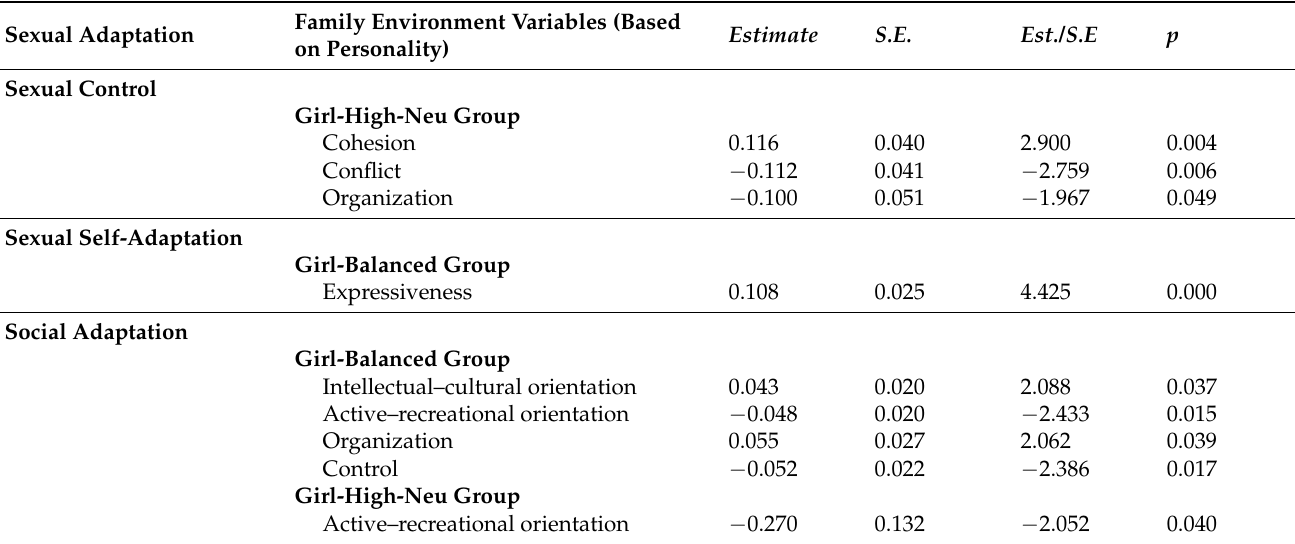
Table 4. Mixture regression model of family environment and adolescent’s sexual adaptability (personality latent category variables as the